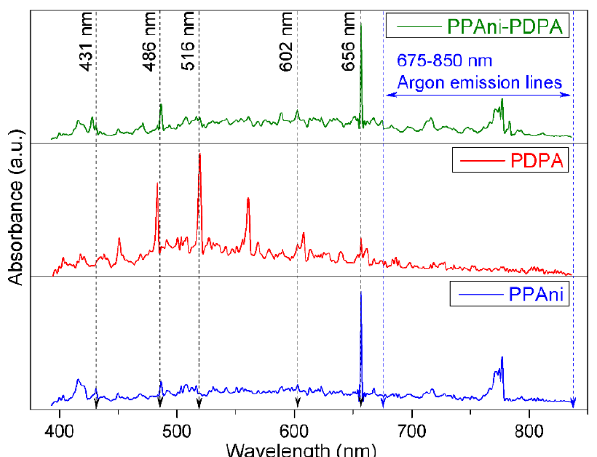
Figure 2. Plasma emission spectra for PPAni, PDPA, and PPAni-PDPA.